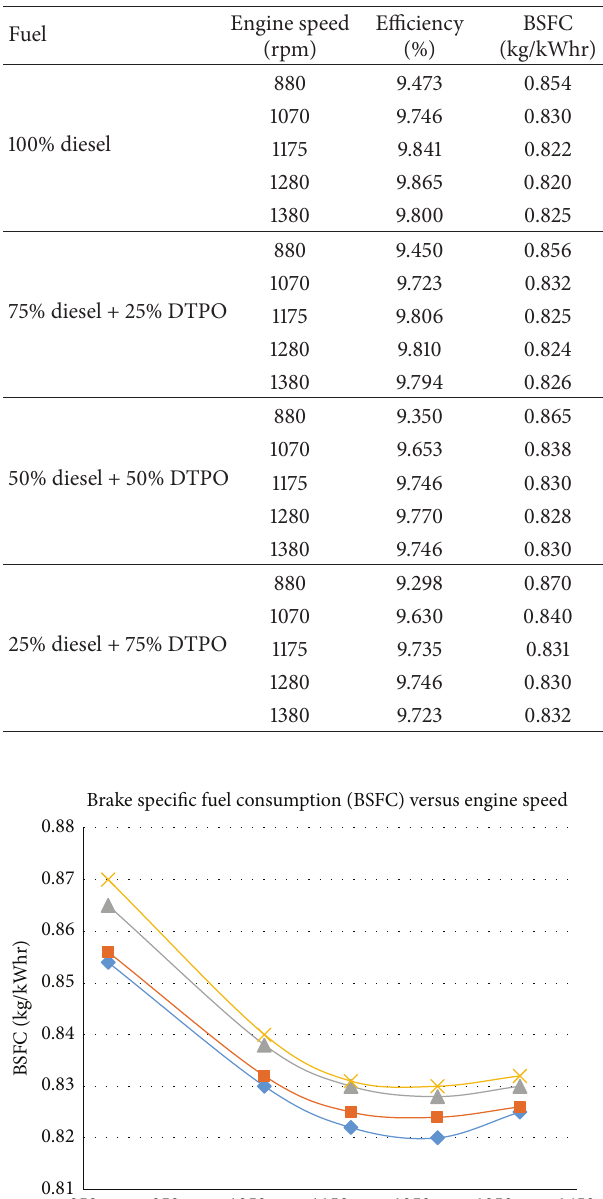
Table 6: Performance test of Beco diesel engine by using 100%, 75%, 50%, and 25% diesel fuel at 27% part load.